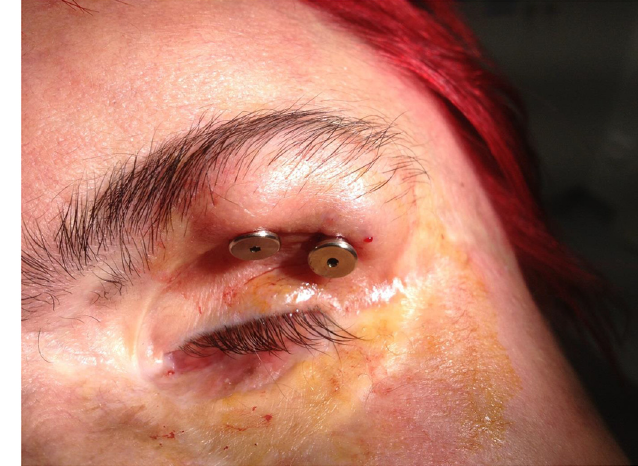
Fig. 2. Extraoral implants for the bearing of